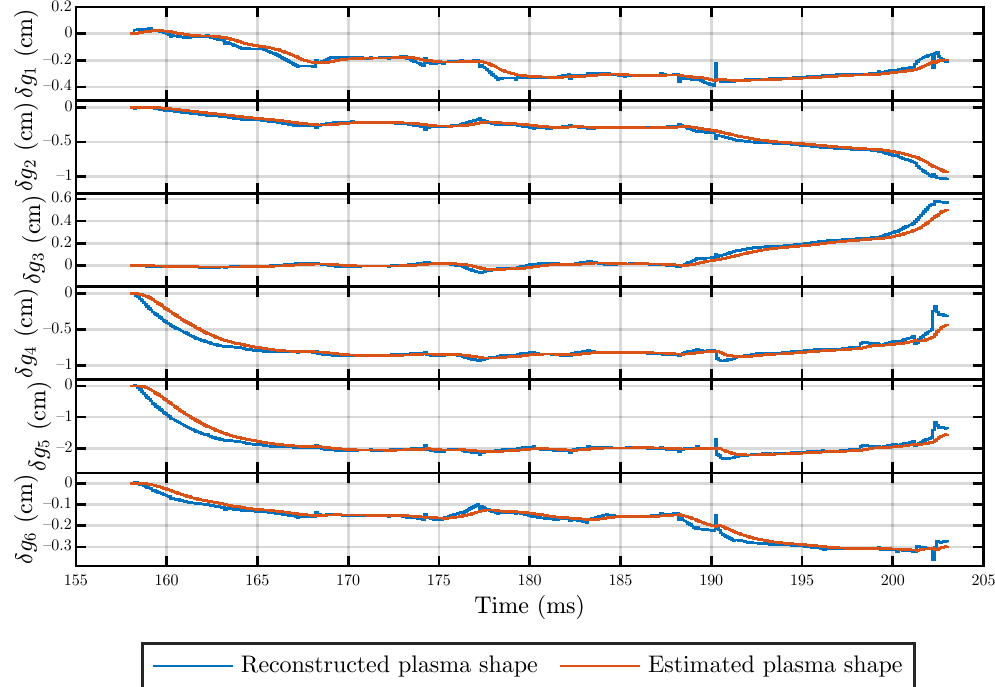
Figure 6. Comparison of gaps variations δ g derived by LPV model obtained from the FCDI code (blue line) and estimation of gap variations δ ˜ g obtained from robust observer synthesized by LMIs (red line). Globus-M2 discharge